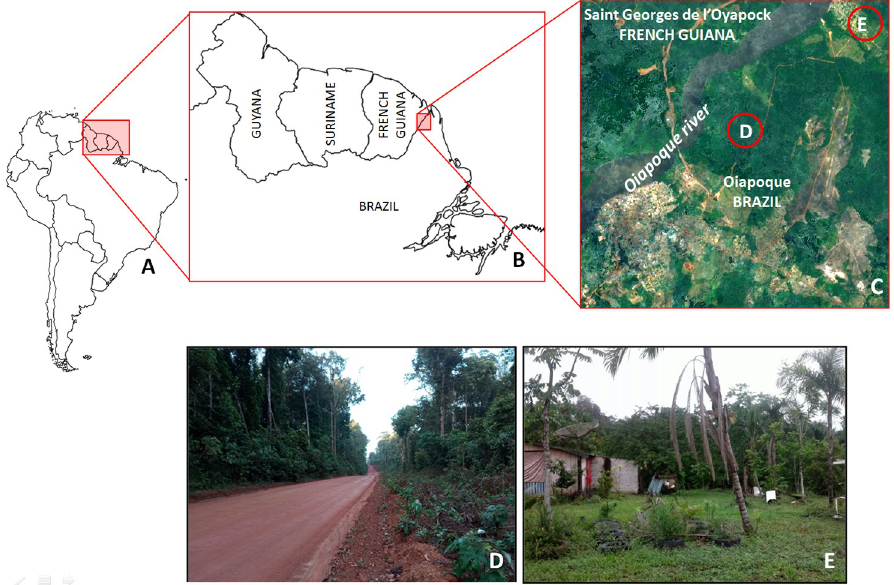
Fig 1. Study area. Located in Guianan Ecoregion Complex, South America (A), the border area between Brazil and French Guiana (B) is socioeconomically linked by the Brazilian municipality of Oiapoque and the French Guianan comune of Saint Georges de l’Oyapock (C), where ACL seems to be occurring in both wild (D) and anthropized (E) environments.